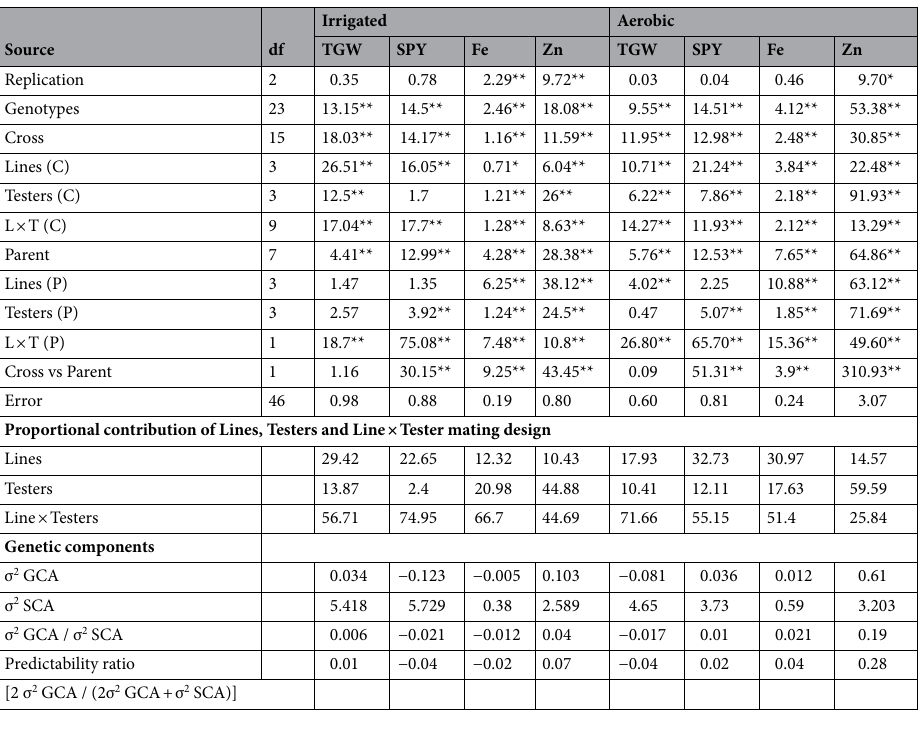
Table 3. Mean squares and genetic components for TGW, SPY, Grain Fe and Zn densities in Line × Tester (Including parents) mating design in Irrigated and Aerobic methods. df—Degrees of freedom; *P < 0.05; **P < 0.01. TGW—1000 Grain Weight; SPY—Single Plant Yield; Fe—Grain Fe content; Zn—Grain Zn